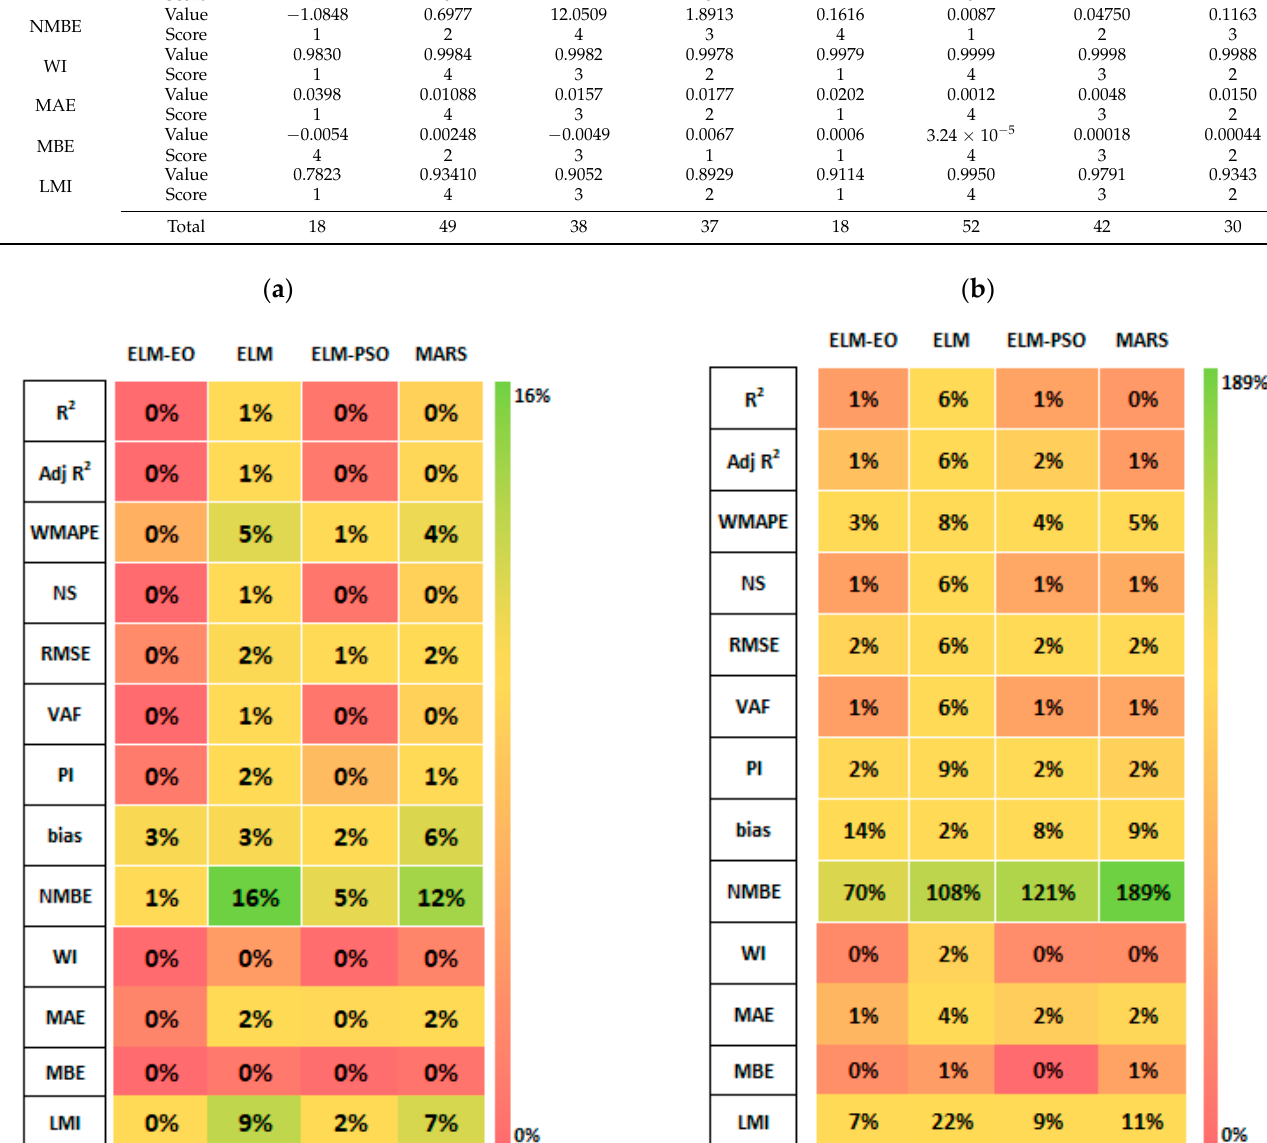
Figure 3. Error matrices for the applied models for ( a ) training dataset and ( b ) testing dataset.